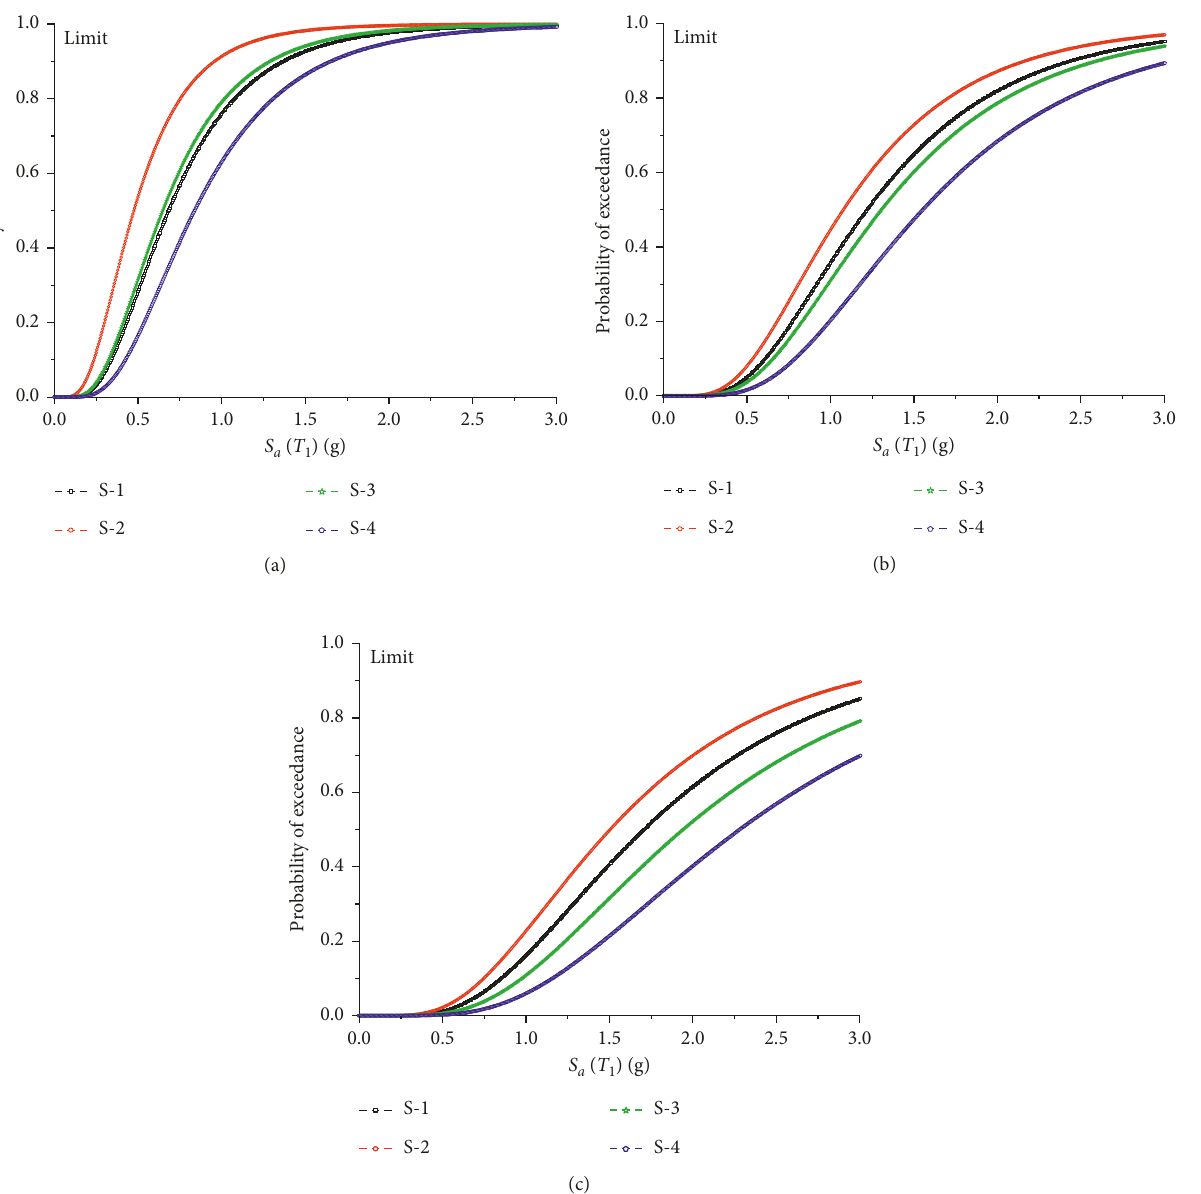
Figure 13: Fragility curves of the buildings S-1, S-2, S-3, and S-4. (a) IO, (b) SD, and (c)